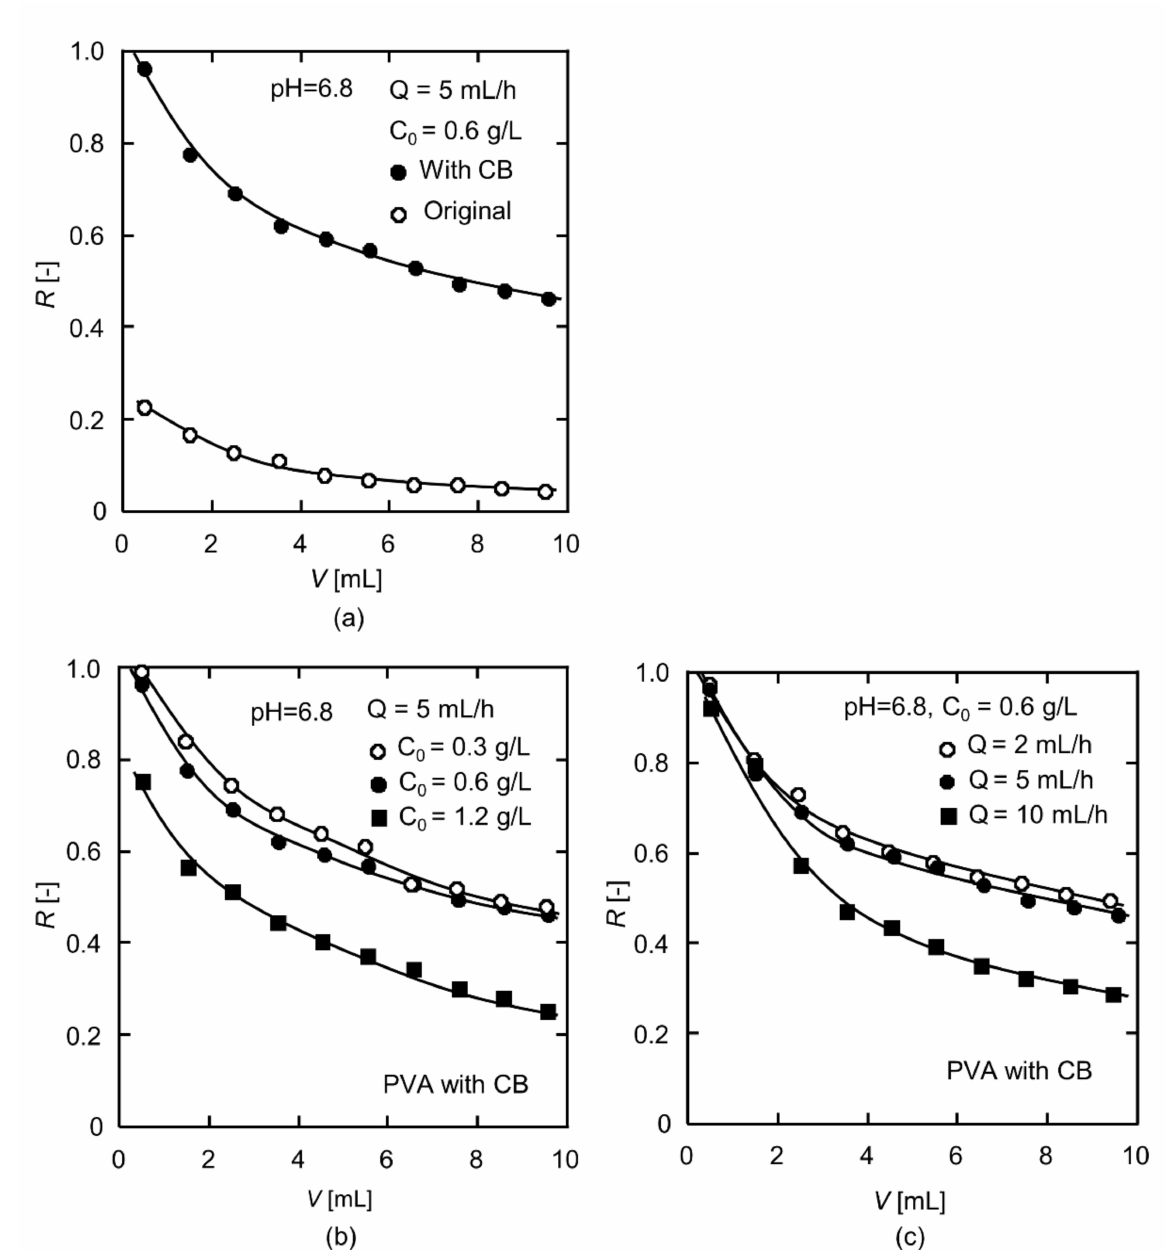
Figure 4. Dynamic adsorption test results for ( a ) the original and CB-modified PVA nanofiber fabrics, ( b ) the effect of feed concentrations on the CB-modified PVA nanofiber fabrics, and ( c ) the effect of permeation rates on the CB-modified PVA nanofiber